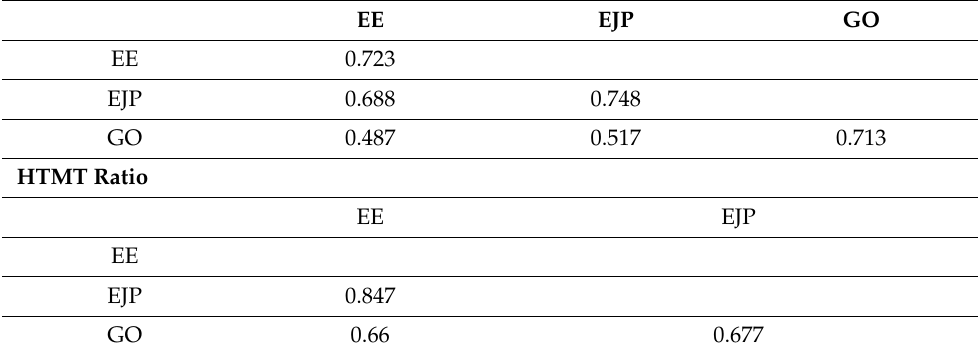
Table 4. Discriminant Validity—Fornell–Larcker